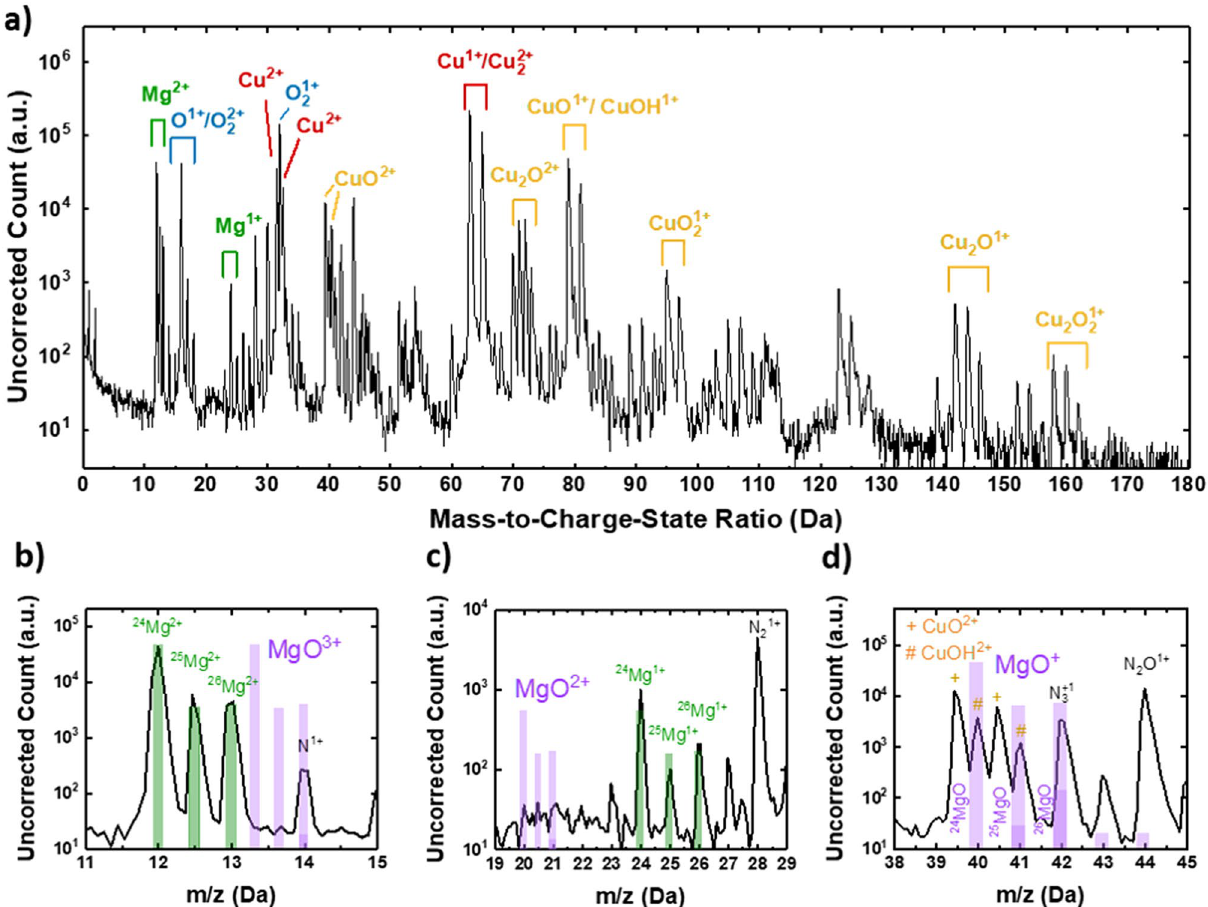
Figure 1. Atom probe mass spectra averaged over the volume corresponding to the as-deposited Cu 2 O:Mg film. The ions collected from the Si substrate are not shown for clarity: ( a ) full mass spectrum with the relevant atomic and molecular ion species highlighted; ( b – d ) show selected regions of the spectrum shown in ( a ), in which the location and abundance of the peaks originating from Mg nx ions and MgO x nx ions shown by green and purple bars,